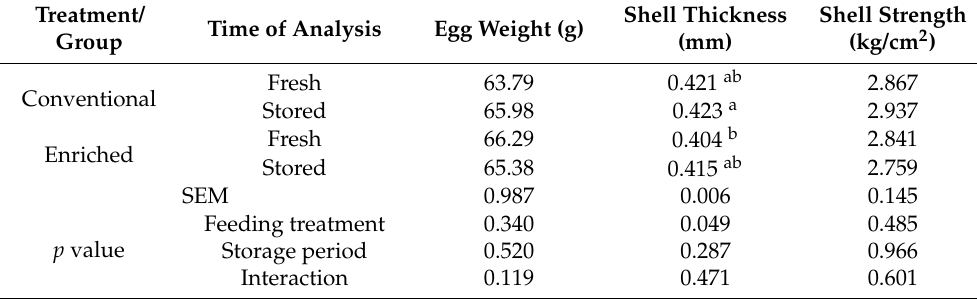
Table 4. Influence of feeding treatments on external egg quality